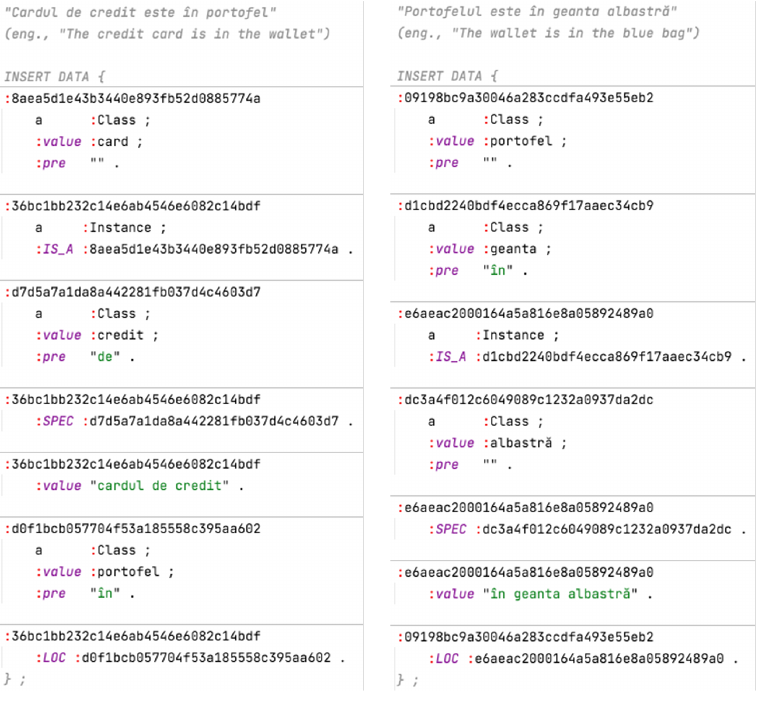
Figure 6. SPARQL queries for inserting dynamic information into the knowledge graph.